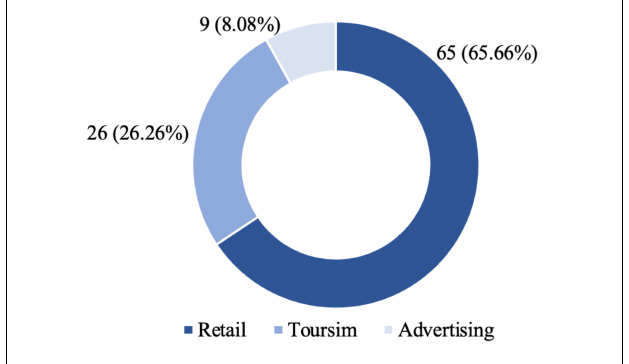
FIGURE 4 | Application area.